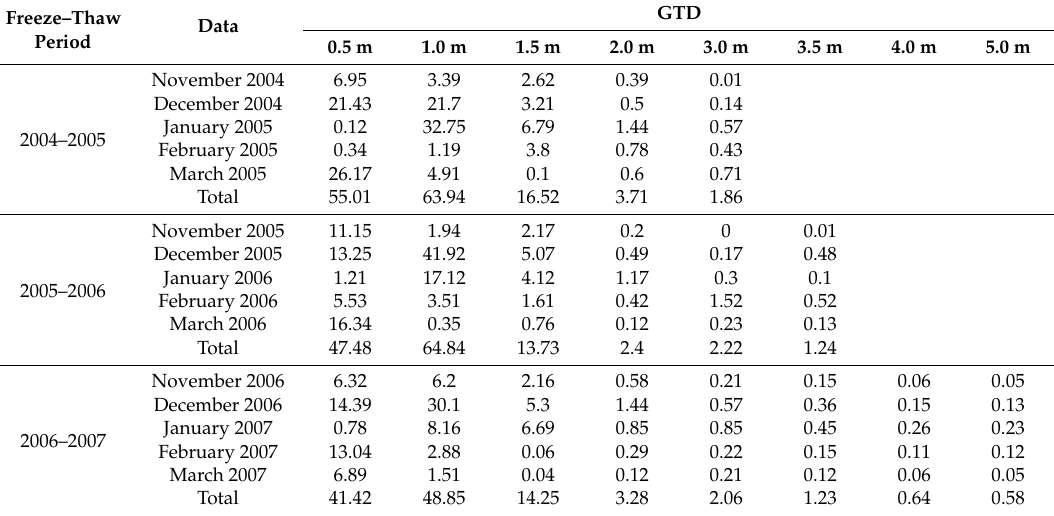
Table 6. Phreatic evaporation of sandy soil during freeze–thaw periods. Unit: Millimeters. Freeze–Thaw